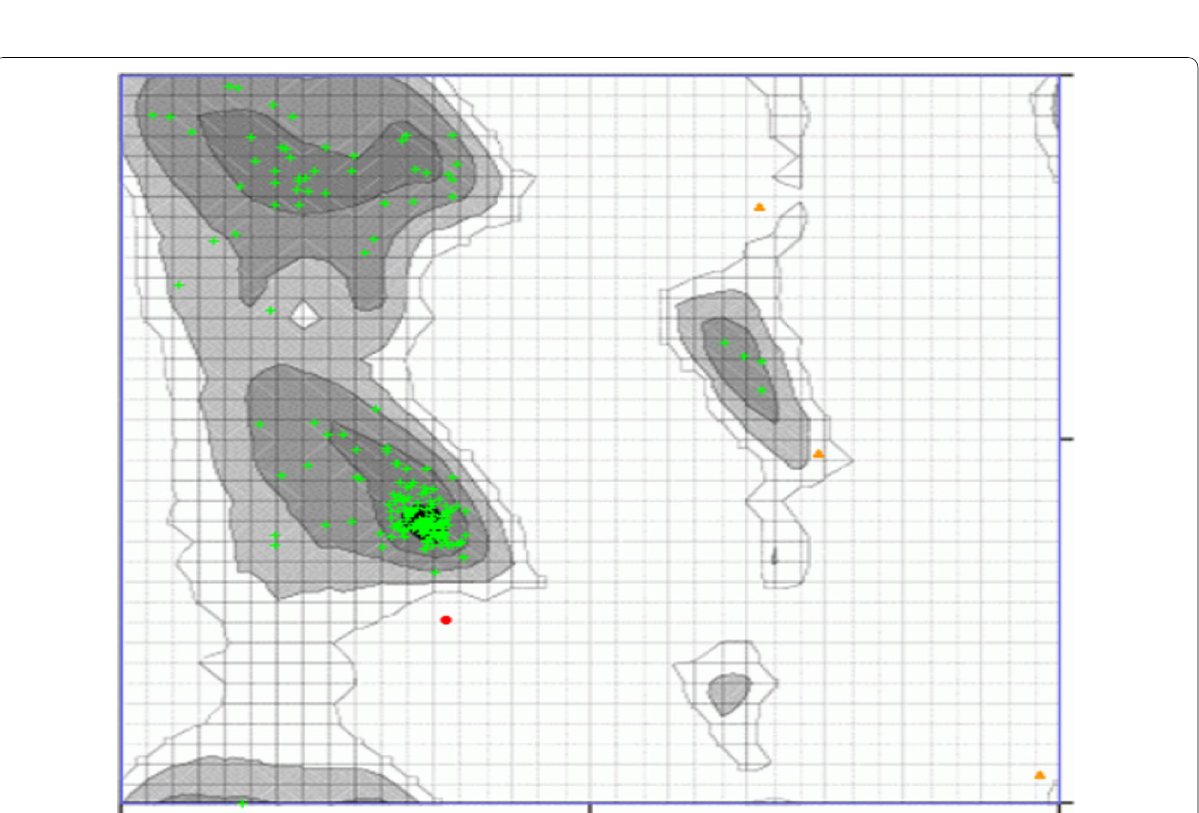
Fig. 7 G. mellonella GST protein structure by Ramachandran plot with 98% of amino acids (https:// zlab. umass med.